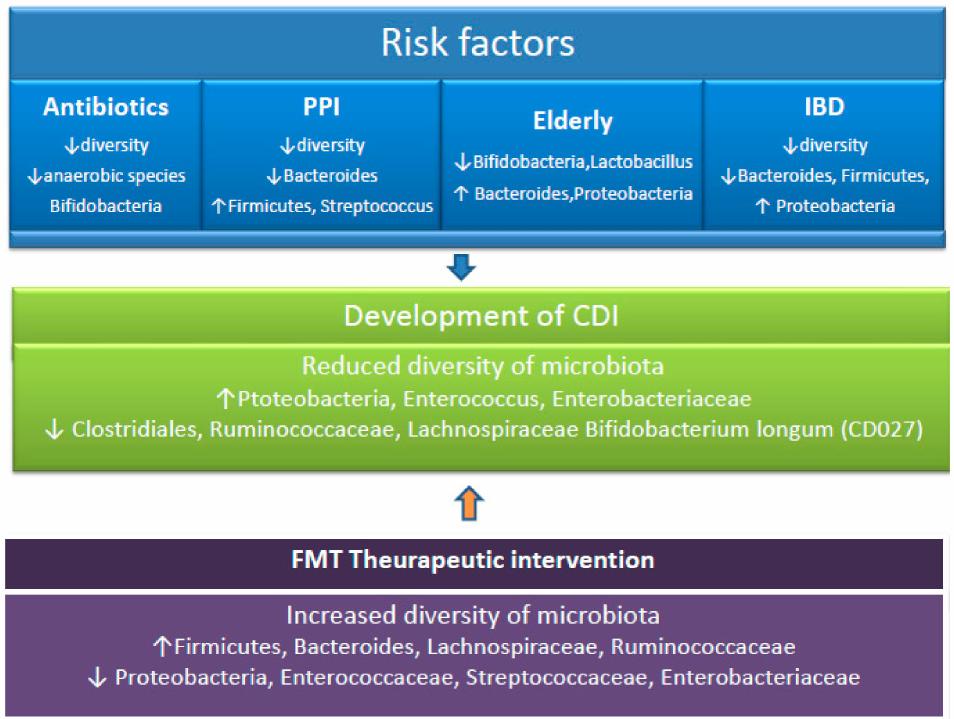
Figure 2. Taxonomic alterations associated with CDI risk factors. Following exposure to CDI risk factors, the microbiome is altered. Disruption of the microbiota due to factors such as antibiotic use, drugs, and prolonged age can lead to the development of CDI. Following fecal microbiota transplantation, the structure and function of the gut microbiota is restored. PPI, proton pump inhibitor. CDI, Clostridioides di ffi cile infection. FMT, fecal microbiota transplantation. IBD, inflammatory bowel disease. ↑ increased. ↓